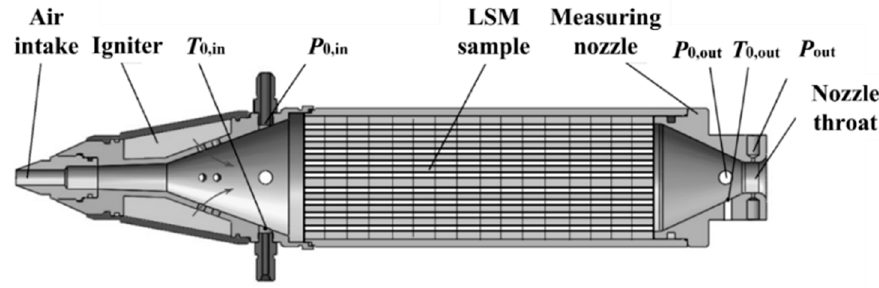
Figure 2. Schematic of flow-through GG.